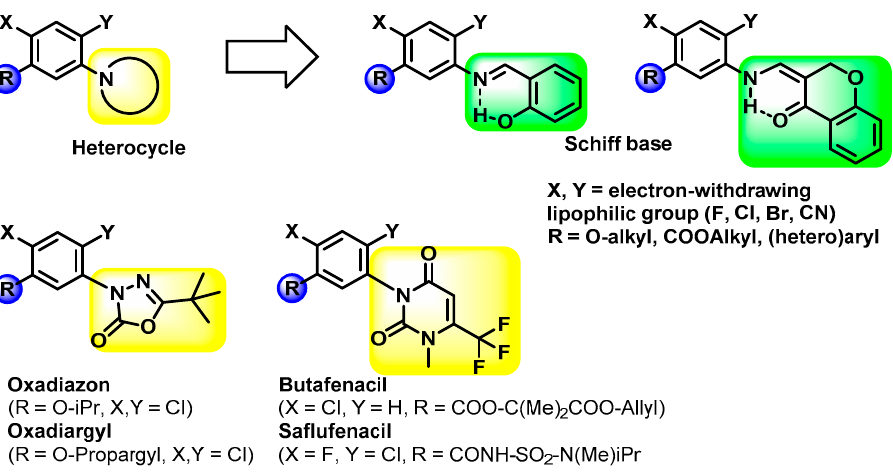
Figure 7. Design of Prepared Synthetic hPPO Inhibitors.